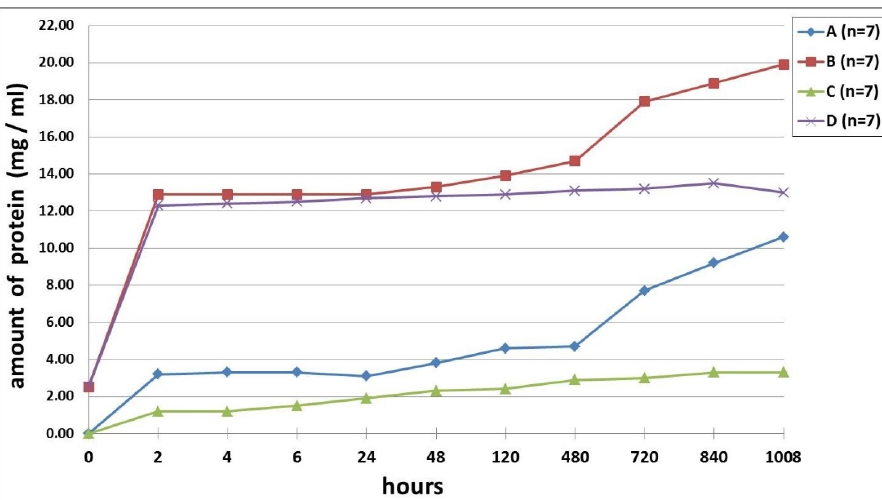
Figure 6. Biodegradation of hydrogel scaffolds in vitro. ( A , C ) Passive biodegradation of scaffolds in a PBS solution. ( B , D ) Biodegradation of scaffolds by the action of a hydrolytic enzyme—trypsin. ( A , B ) Biodegradation of sca ff olds administered into the experiment after 24 h of cultivation. ( C , D ) Biodegradation of sca ff olds, administered into the experiment after cultivation for six days. Note: The percentage of mistake of the determination was